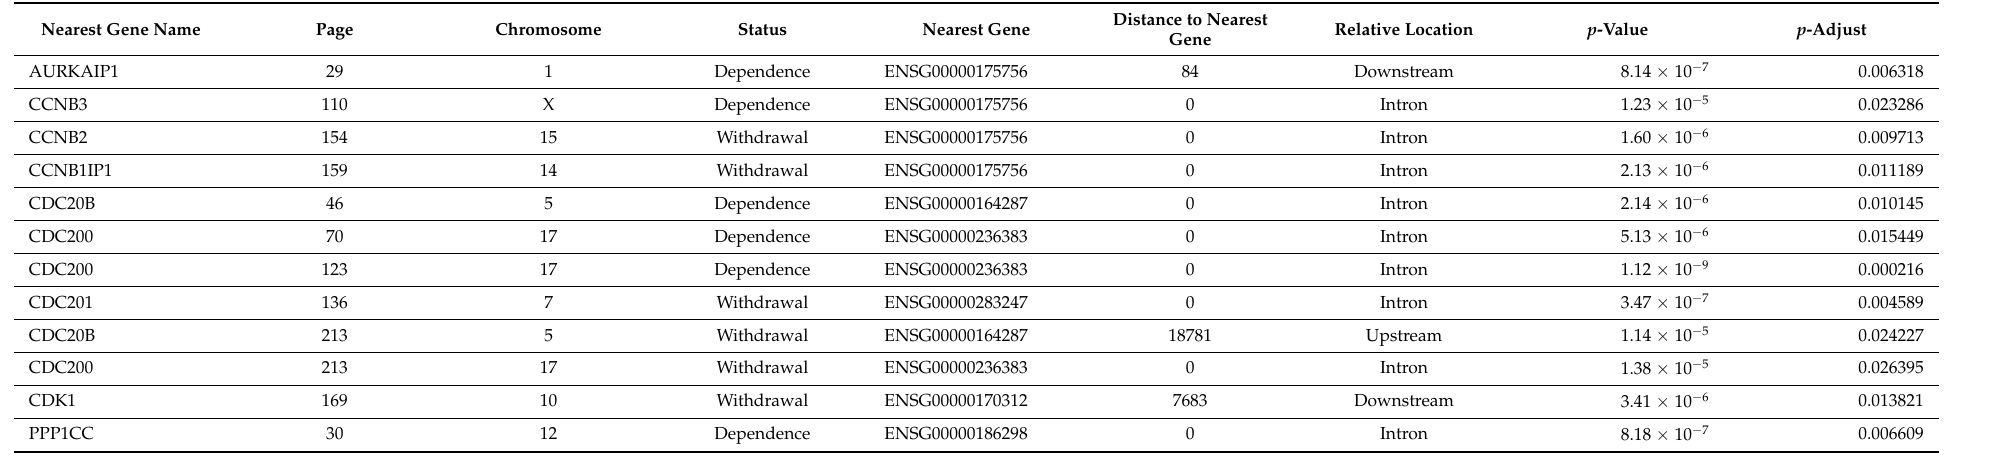
Table 14. EWAS Hits on Kinetochore Metaphase Signaling Pathway; Data from Schrott [47].